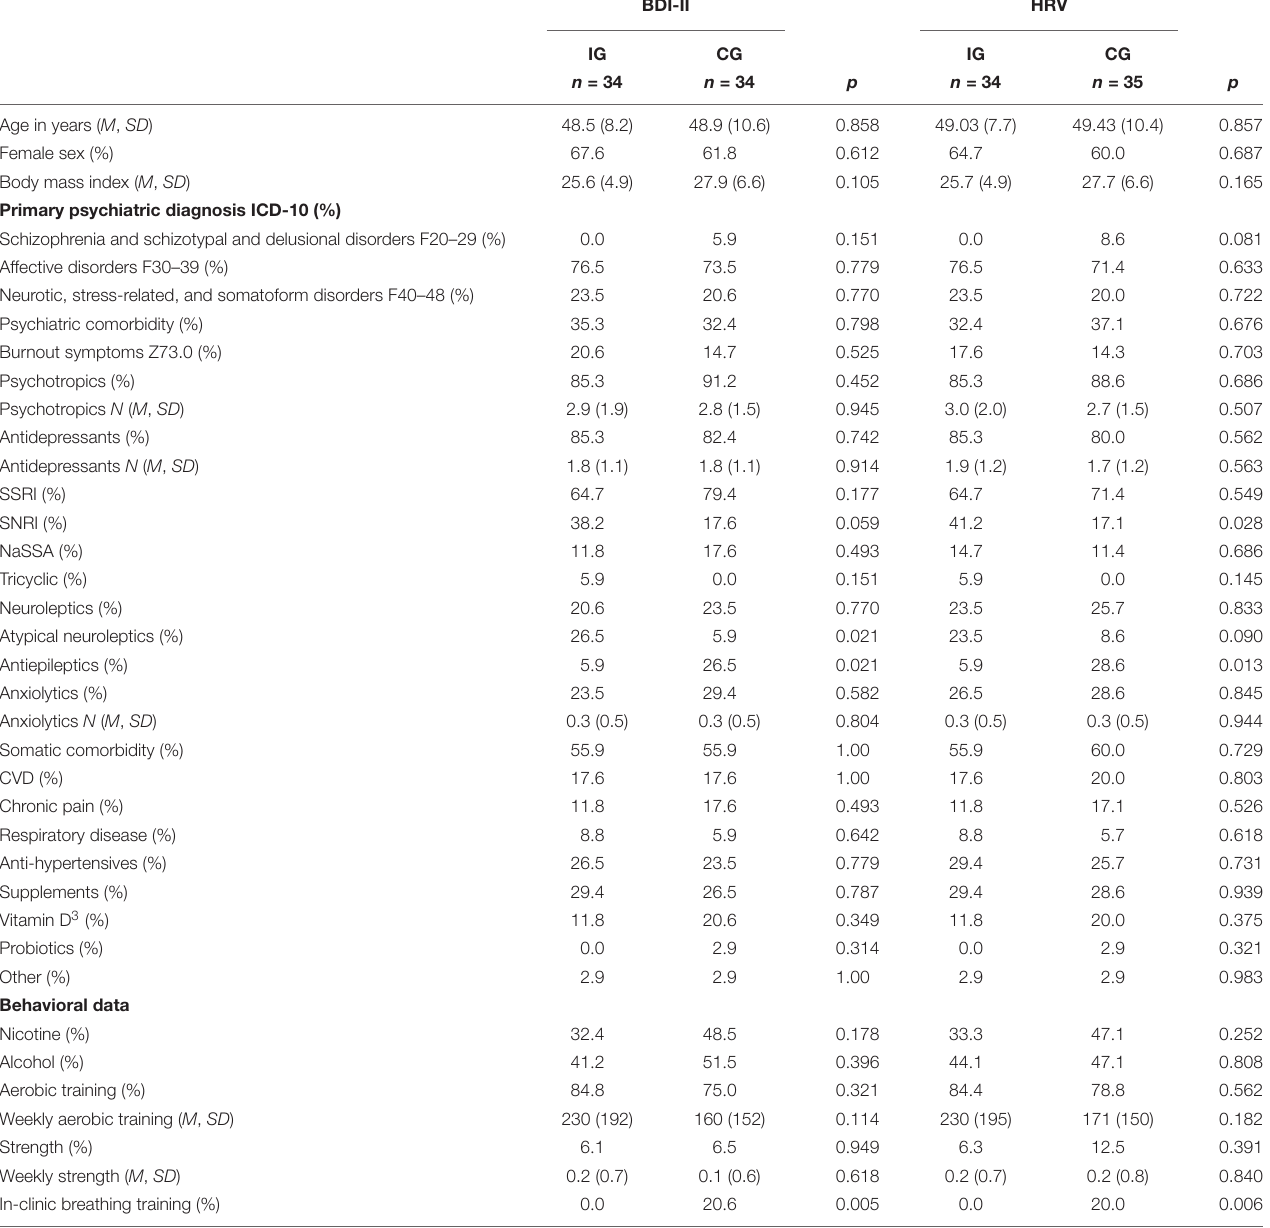
TABLE 1 | Demographic information for the BDI-II and HRV pre–post analyses, between